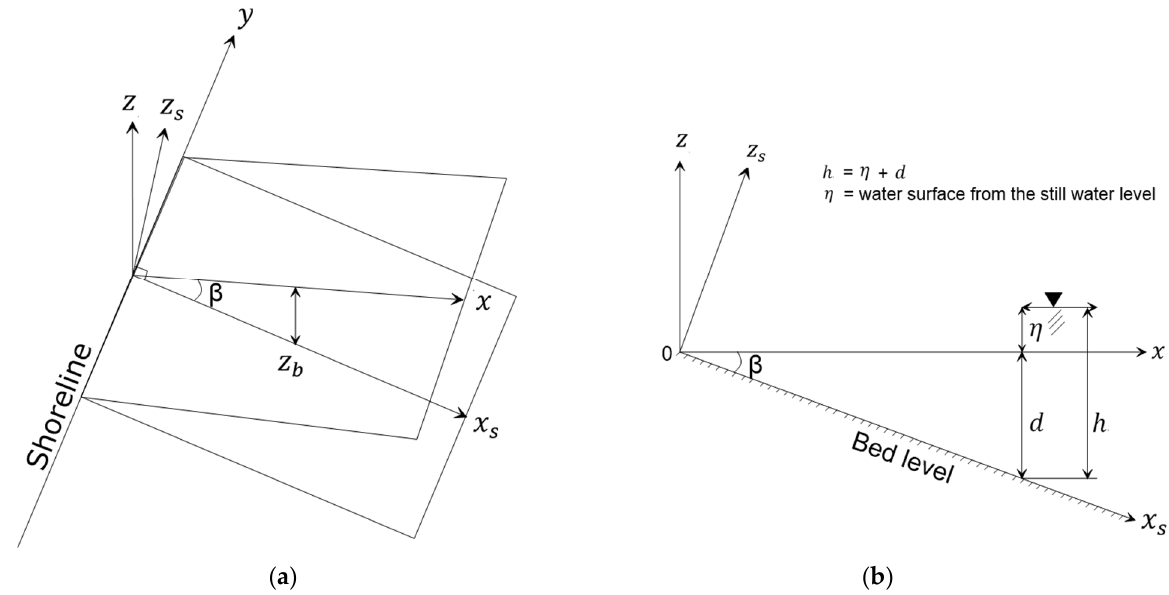
Figure 2. Description of the two coordinates: ( a ) three-dimensional view; ( b ) x − z section. The governing equation of an edge wave is the Laplace equation derived from the fluid mass conservation.